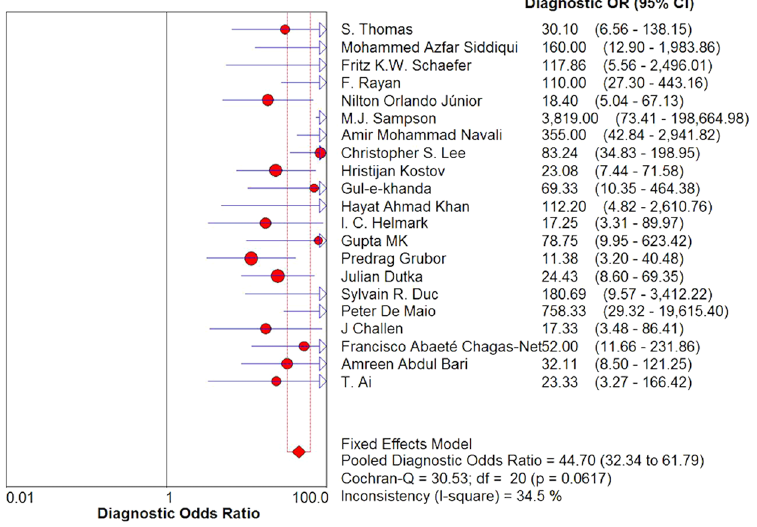
Figure 5. Forest plot of DOR with 95% CI. The DOR, 95% CI and the pooled DOR are represented by red circles, horizontal lines and red diamonds, respectively. DOR: diagnostic odds ratio; CI: confidence interval.